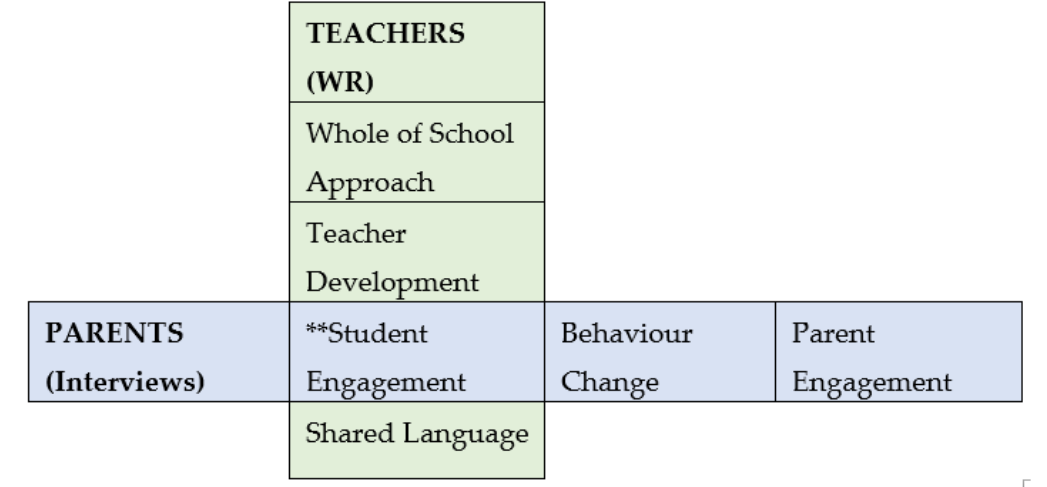
Figure 1. Student engagement is the central theme from both teacher and parent data. WR—written reflections (teacher).